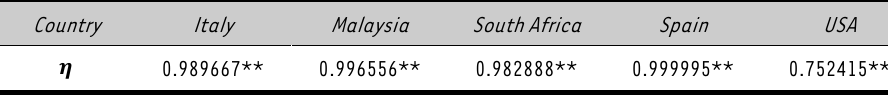
TABLE 10: Expenditure elasticities for UK tourists Country